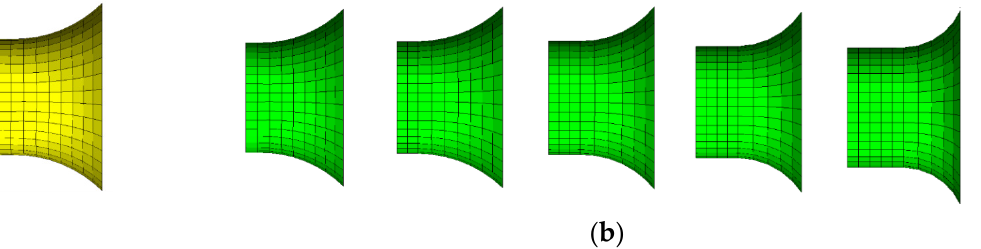
Figure 6. Seed disk hole grid: ( a ) Seed disk hole grid with different structures, ( b ) seed disk hole grid with different groove depths.